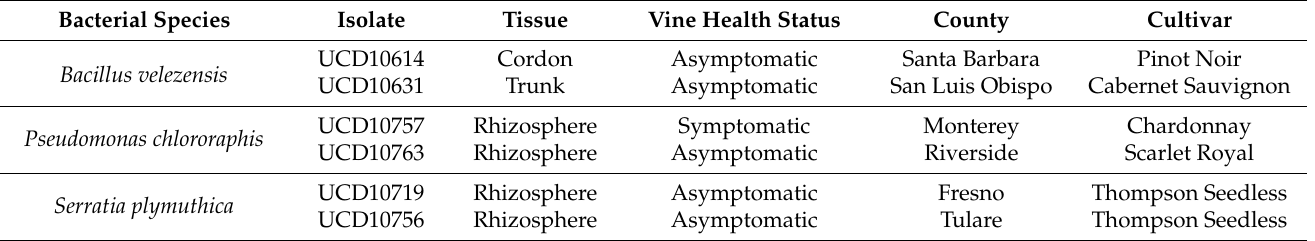
Table 1. Selected isolates of endophytic and rhizospheric bacteria obtained from commercial grapevines in California for in vitro antagonism and metabolite assays against GTD-causing pathogens. Bacterial